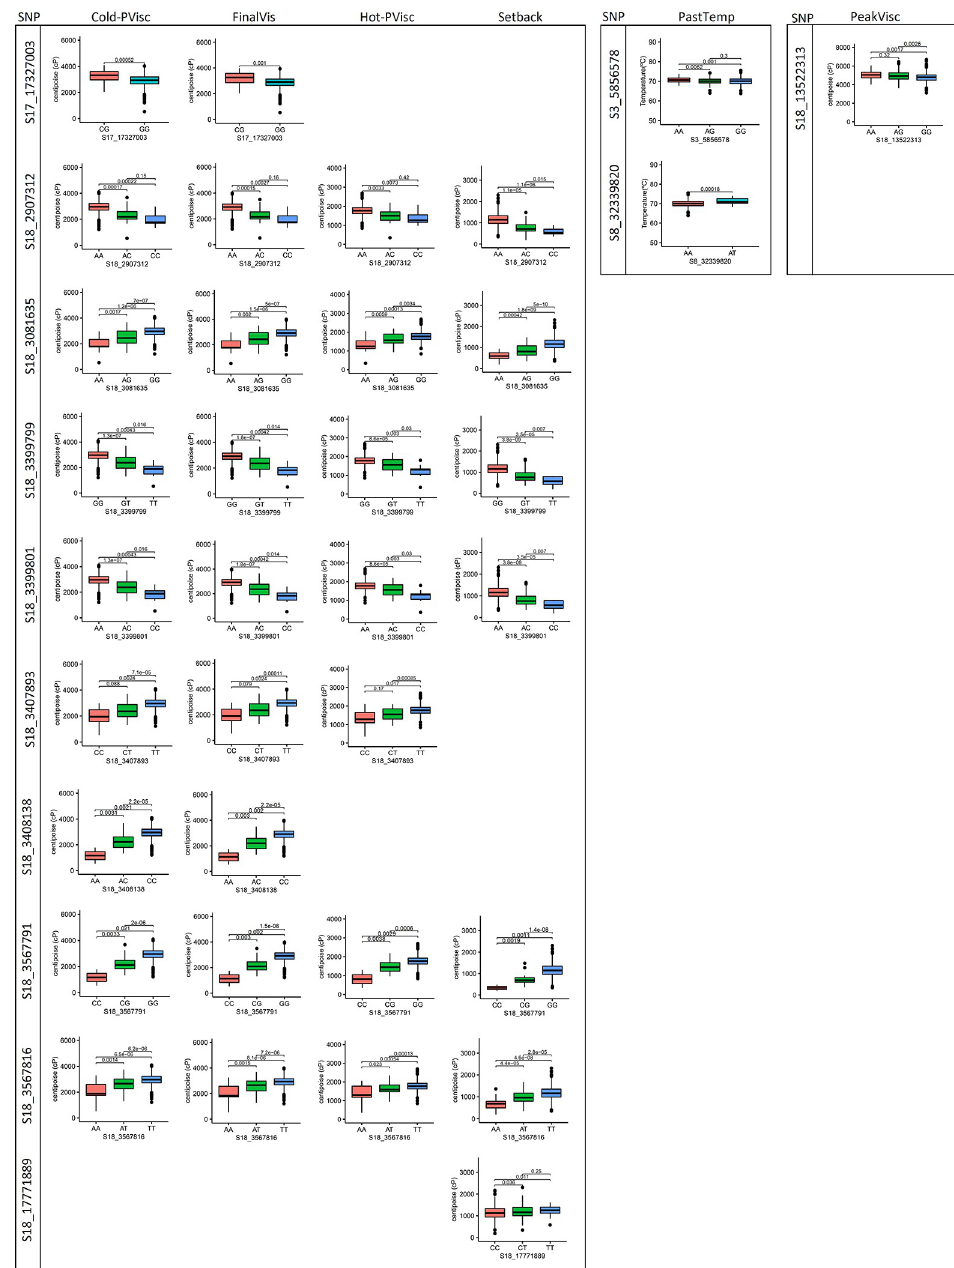
Fig 5. Analysis of build-up effect for different SNP genotypes associated with pasting temperature (PastTemp), peak viscosity (PeakVisc), hot paste viscosity (Hot-PVisc), cool paste viscosity (Cold-PVisc), final viscosity (FinalVis), and setback (Setback). The x-axis represents the SNP genotypes carried by the cassava accessions, and the y-axis represents trait mean value. The p-value of the t-test comparison (p < 0.05) is plotted for each